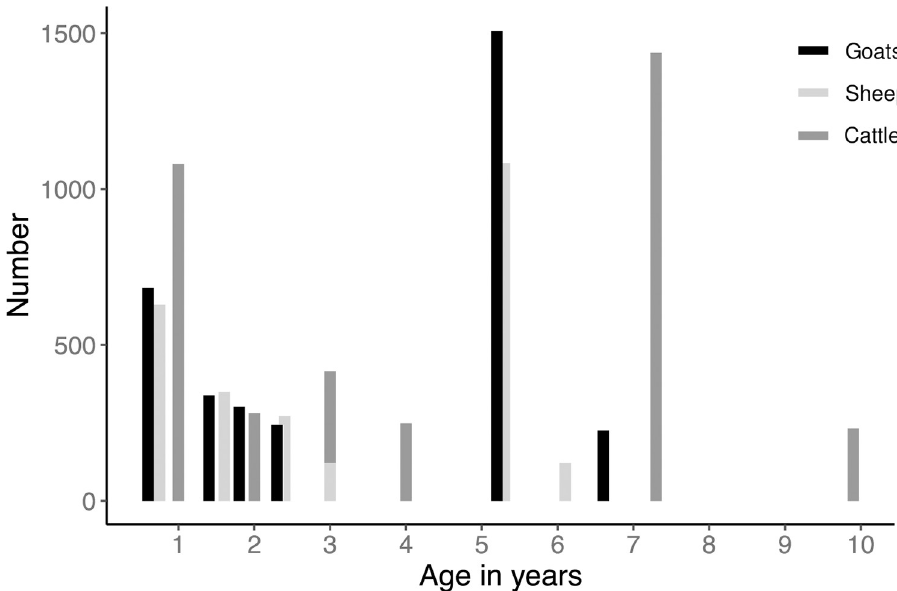
Fig 1. Number of cattle, goats, and sheep sampled by age from two cross-sectional serosurveys conducted in 2013 through 2016 in Arusha, Manyara and Kilimanjaro Regions, Tanzania.